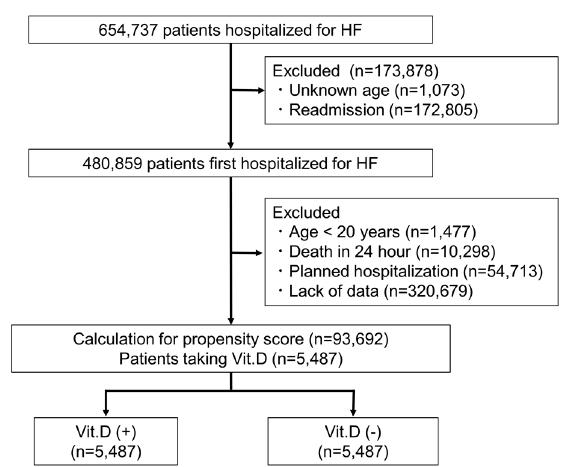
Figure 1. Flowchart of this study. HF, heart failure; Vit D, vitamin D supplementation.